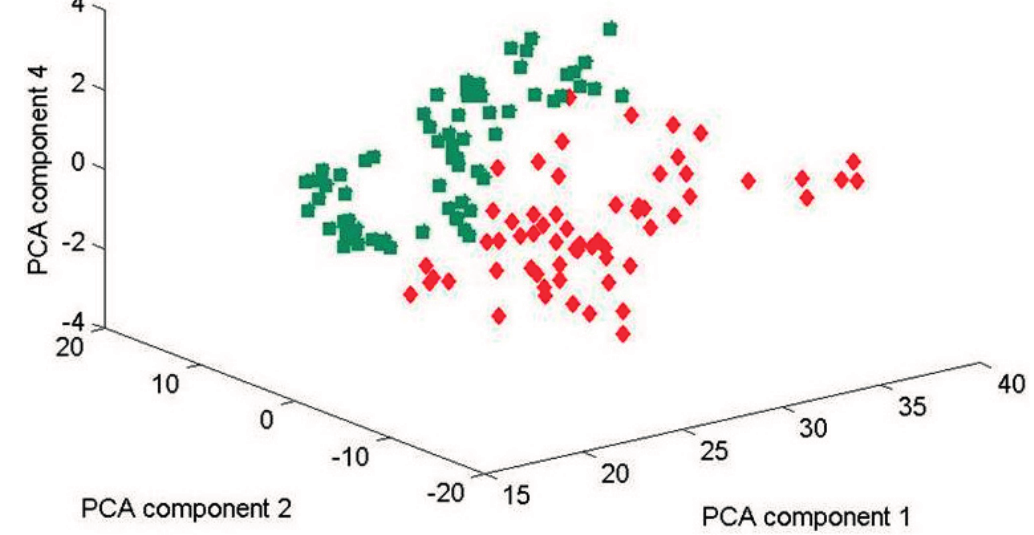
Figure 7. Plot of loadings of ( a ) PC1; and ( b ) PC2 corresponding to Figure 5.